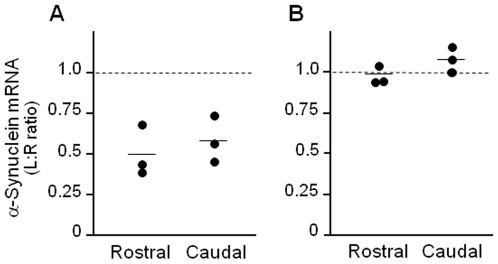
Measurement of nigral α-synuclein mRNA by qPCR.Squirrel monkeys received unilateral nigral infusion of siRNA targeting α-synuclein (A) or luciferase (B). Nigral tissue was dissected from midbrain sections rostral and caudal to the exit of the 3rd nerve. Values are the ratio of α-synuclein mRNA levels measured by qPCR in the left (siRNA-infused) and right (untreated) substantia nigra (L∶R ratio). Bars represent mean values.